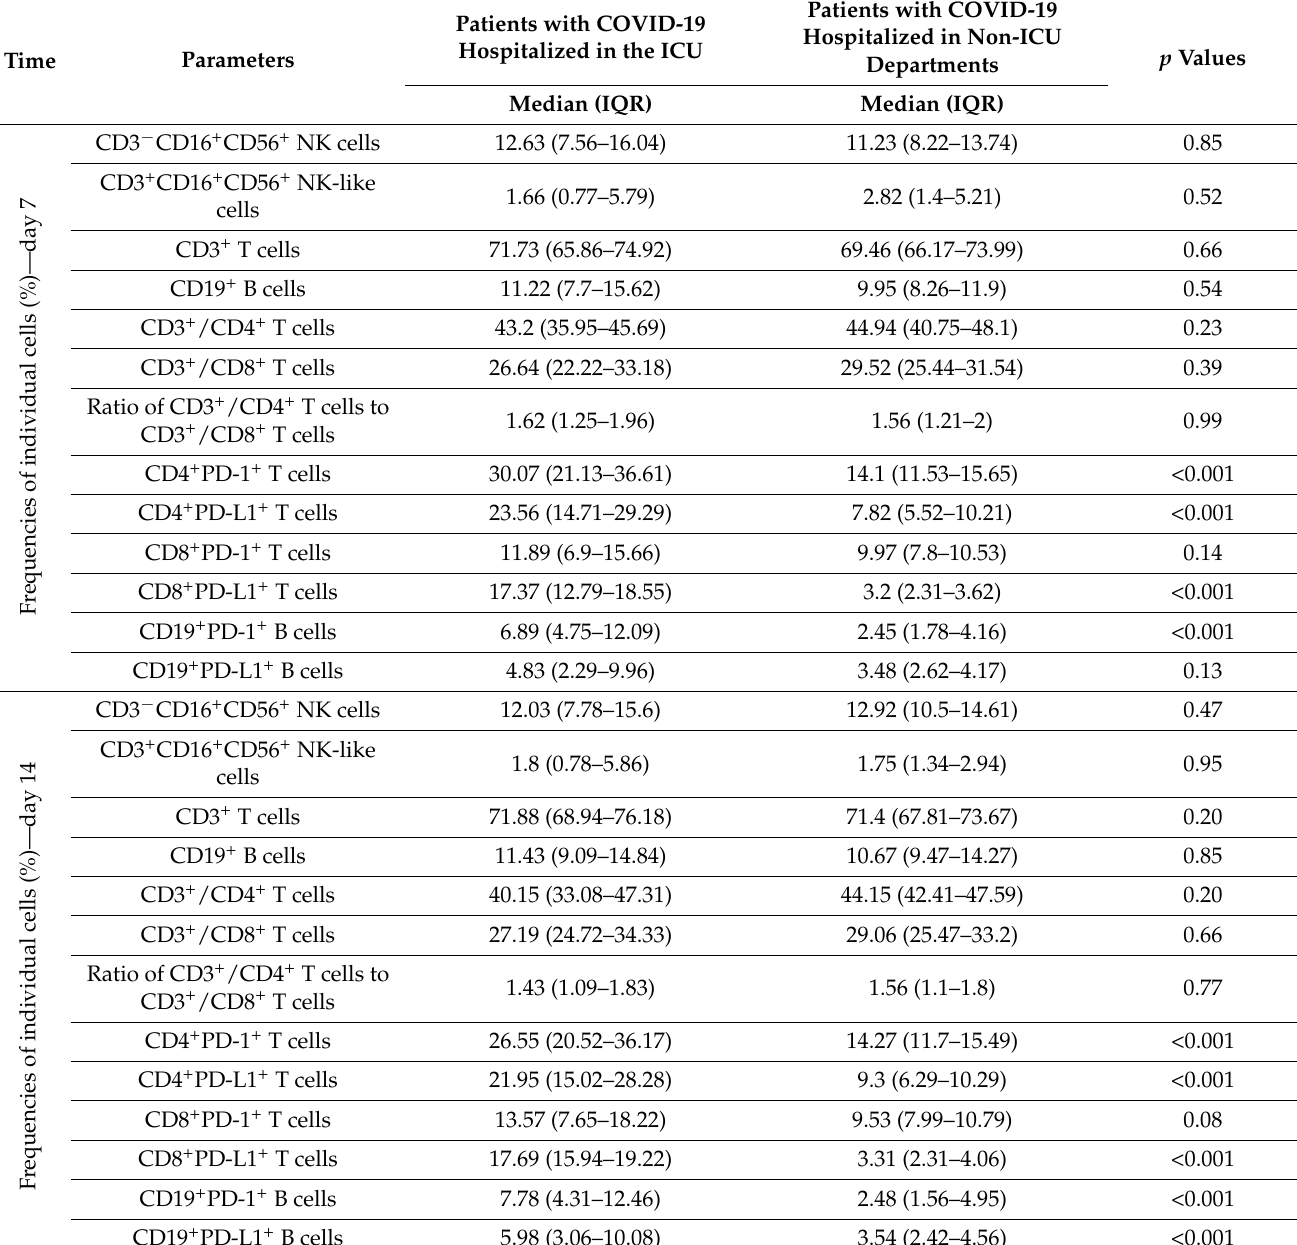
Table 3. Changes in selected immunophenotype parameters during hospitalization in patients with COVID-19 on days 7 and 14 of in-hospital